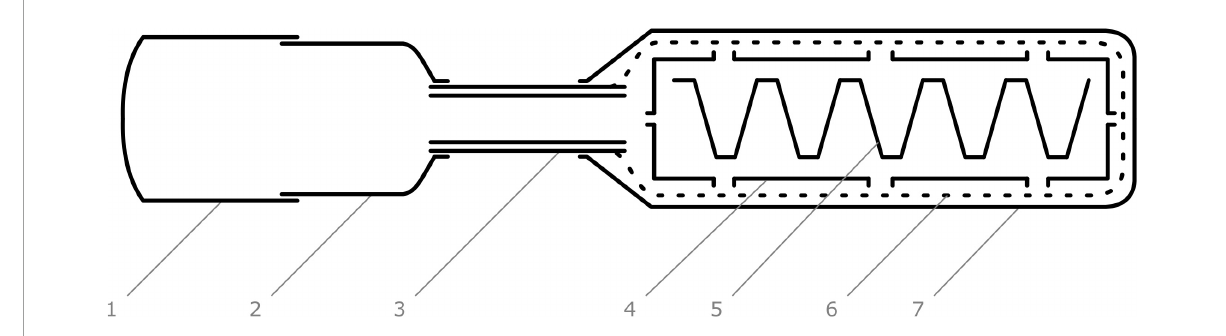
FIGURE1 Cross-section of artificial hibernaculum, state at the time when spring emigration of adults was studied. Individual components are marked with labels. 1–collection bottle, lower part, 2–collection bottle, upper part, 3–plastic tube, 4–overwintering box, 5–egg cardboard, 6–gauze bag, 7–opaque plastic